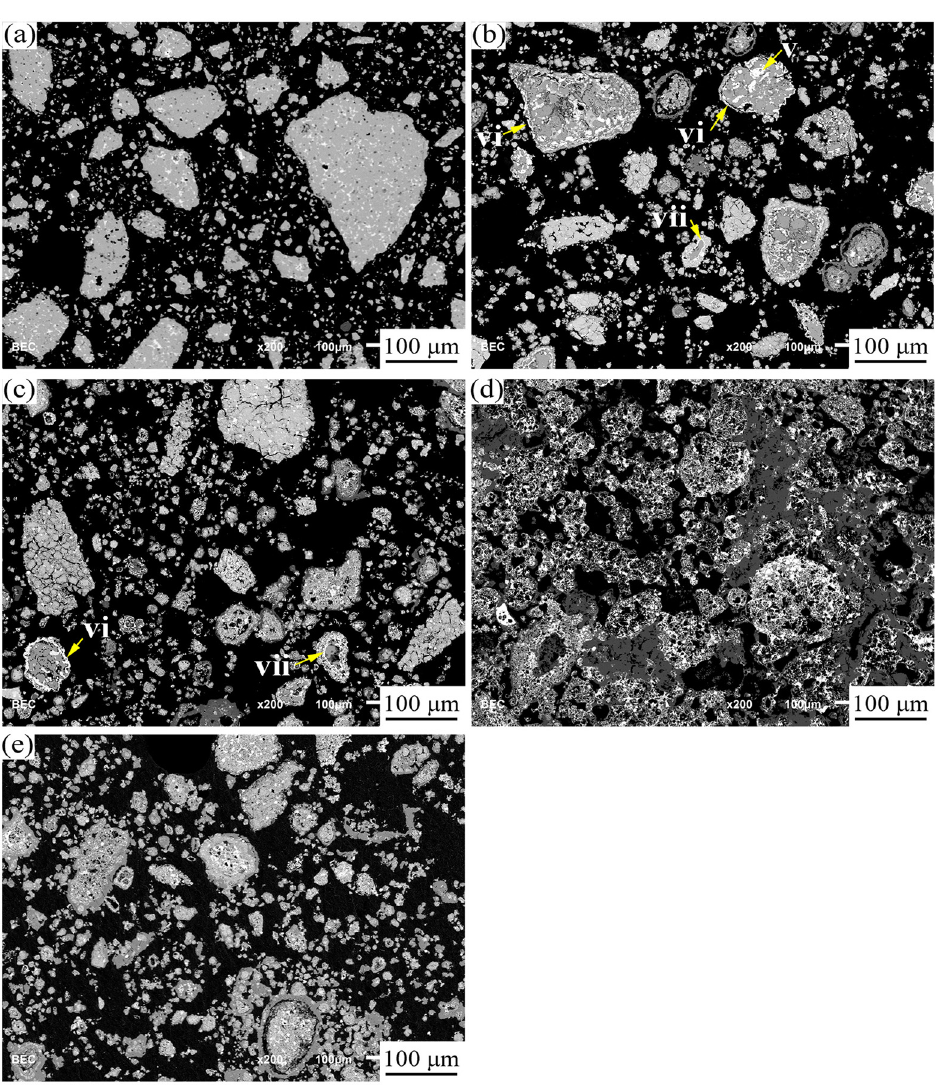
Figure 5: BSE images of the microstructure of the Ce – Fe – B magnet scrap powder roasted at 800°C with di ff erent roasting times. ( a ) The unroasted Ce – Fe – B scrap powder; ( b ) fi rst cycle of roasting; ( c ) second cycle of roasting; ( d ) third cycle of roasting; ( e ) fourth cycle of